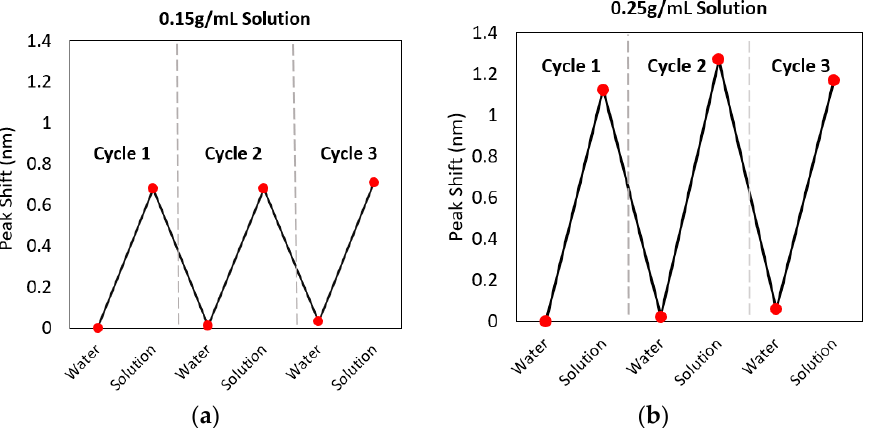
Figure 6. Cycling tests between water and ( a ) 0.15 g/mL or ( b ) 0.25 g/mL glucose solutions in the chip. The TM resonance wavelength (at ~600 nm) response is seen to be reversible, opening up the opportunity for continuous monitoring of the refractive index of liquids using this platform.